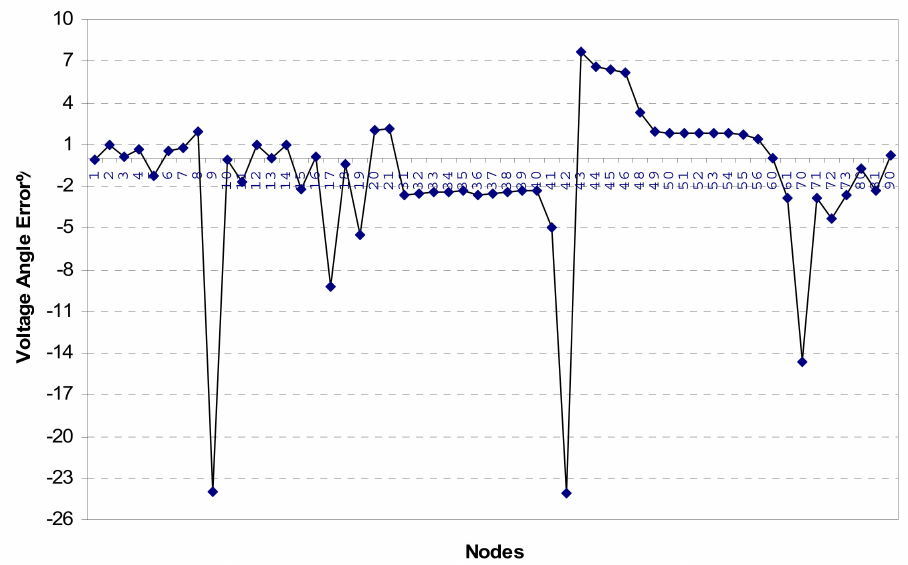
Figure 5. Percent error of the estimated bus voltage angles considering gross errors on the active and reactive load of bus